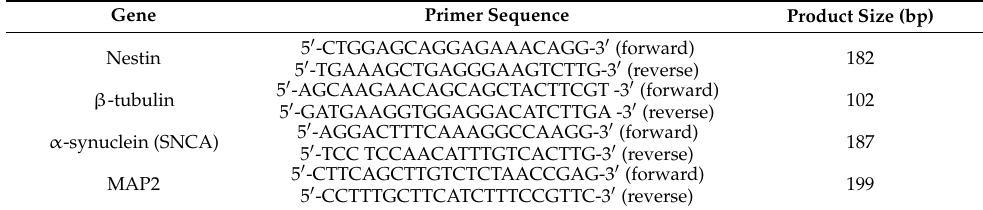
Table 1. List of primers used in RT-qPCR.